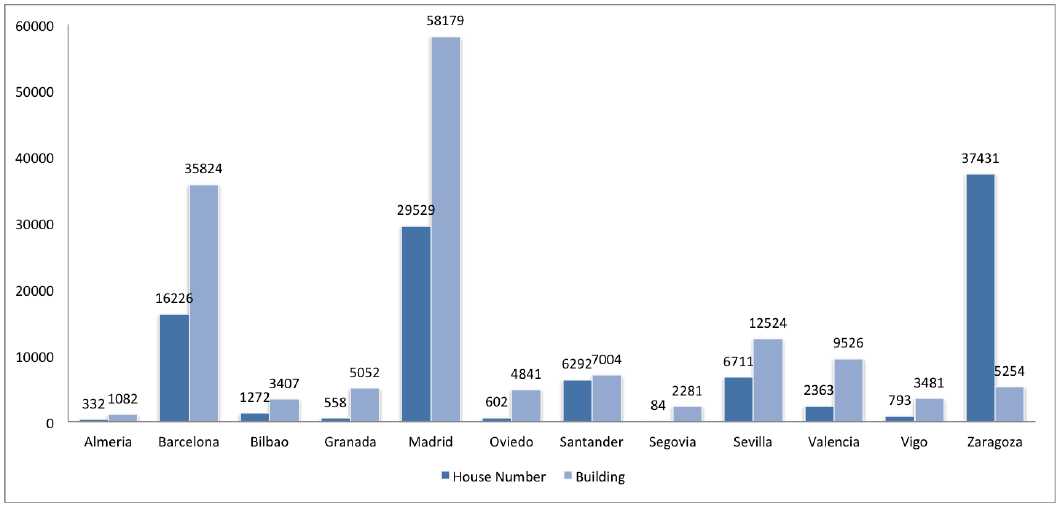
Figure 2. Completeness study in Spain. Proportion of house numbers and